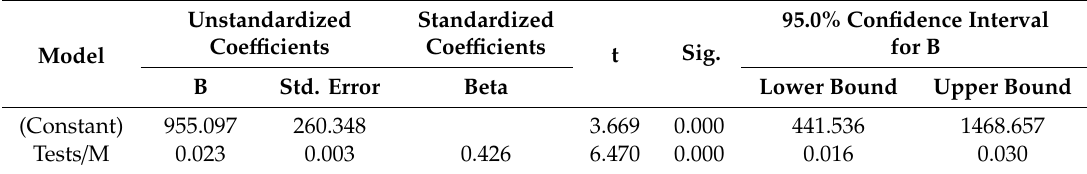
Table 2. Linear regression analysis of the number of cases / million with tests / million as the predictor variable.